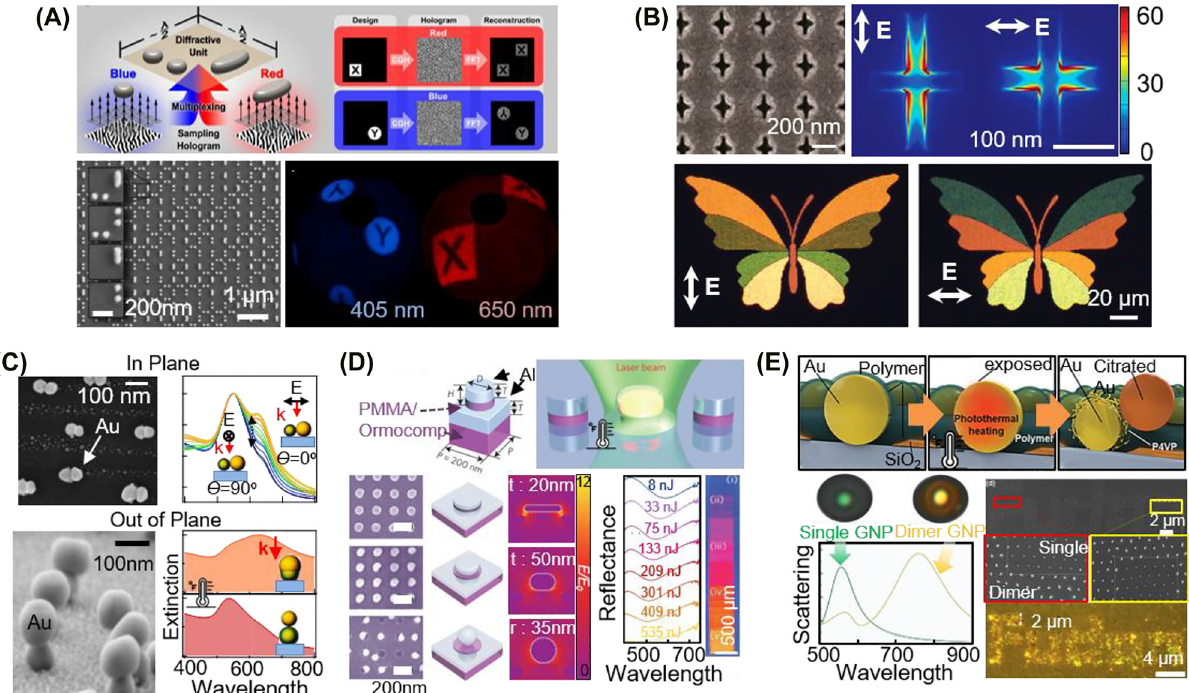
Figure 5: Responsive plasmonic nanopixels with modulation of the shape factor, Δ χ , of the nanoparticle: polarization-dependent coloration with (A) Ag nanostructures and (B) Al nanoholes (reproduced with permission [77, 143], Copyright 2014, Europe PMC and 2016, American Chemical Society), thermally driven shape modulation for coloration with (C) plasmonic dimers (reproduced with permission [144], Copyright 2019, American Chemical Society), (D) Al nanoparticles on Al mirror with PMMA/Ormocomp polymer spacers (reproduced with permission [145], Copyright 2016, American Chemical Society), and (E) gluing of nanoparticles with heat (reproduced with permission [146], Copyright 2021,